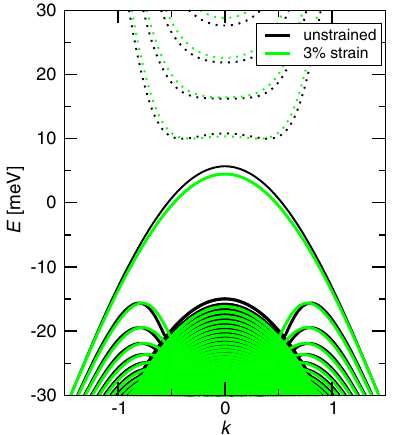
FIG. 6. Band structure of the spin-down sector of Cd 3 As 2 in magnetic field B ¼ 10 T. Two chiral branches are visible at low energies; however, they are now strongly distorted by p-h – symmetry breaking terms, and they no longer traverse the gap between the valence and the conduction